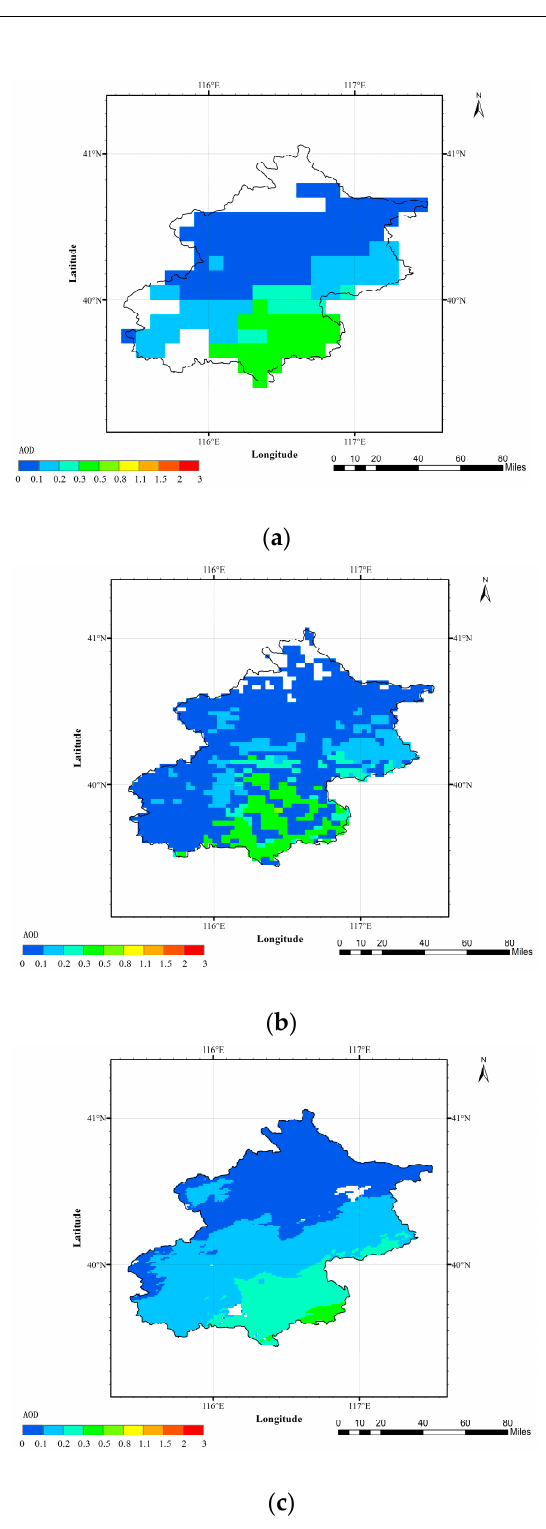
Figure 8. Results of 10 km, 3 km and 1 km MODIS AOD pretreatment in Beijing on October 18, 2020: ( a ) is 10 km AOD result, ( b ) is 3 km AOD result, ( c ) is 1 km AOD